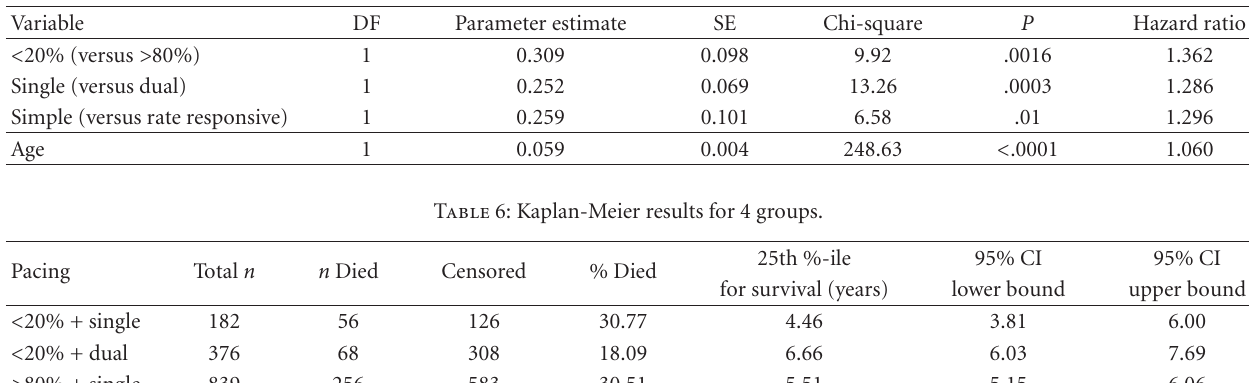
Table 5: Cox regression analysis using < 20% versus > 80% right ventricular pacing, single versus dual pacemaker type, simple versus rate responsive, and age as separate variables.